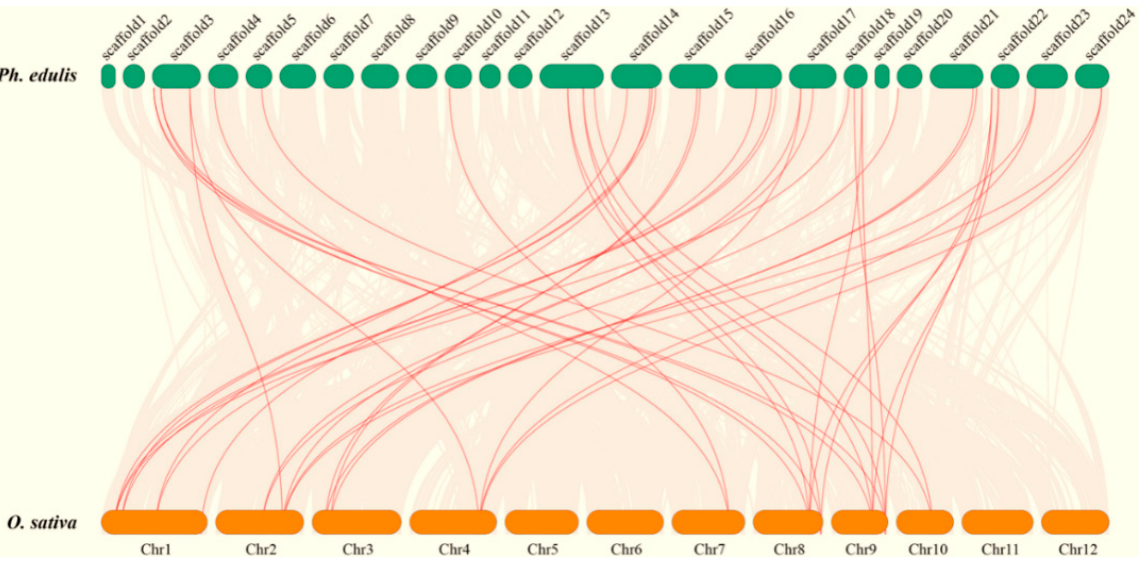
Figure 4. Synteny analysis of the moso bamboo and rice genomes. The gray lines represent aligned blocks between the paired genomes, and the red lines indicate syntenic IDD gene pairs.